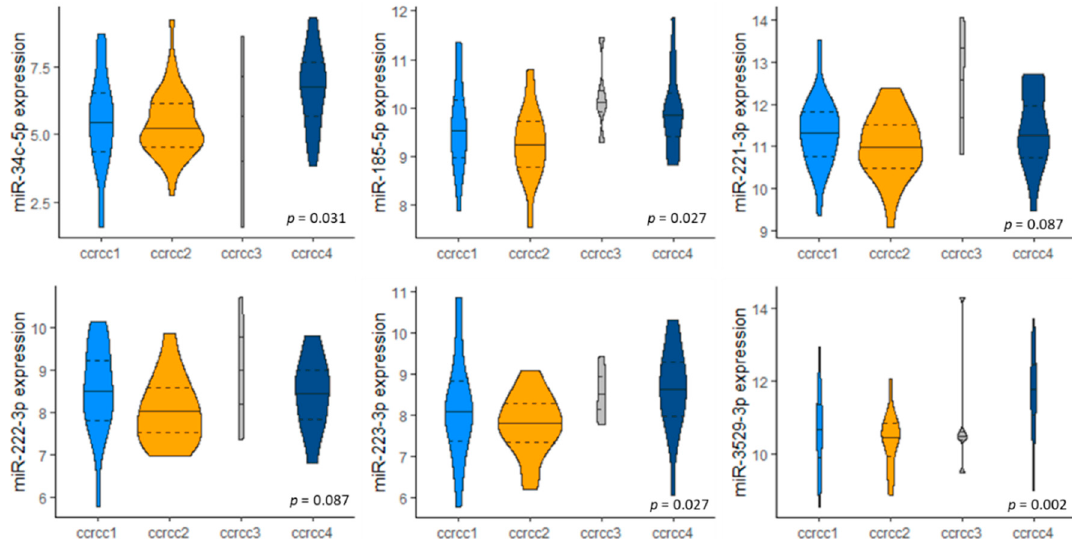
Figure 3. Violin plots of miRNA expression by molecular subtype ccrcc1-4. Note: Molecular subtypes, based on transcrip- tome data were available for 76 samples. Mean values are indicated by a full horizontal line; quartiles are indicated by dashed horizontal lines. p -values as calculated by Kruskal–Wallis test and FDR corrected. Abbreviations: miR =